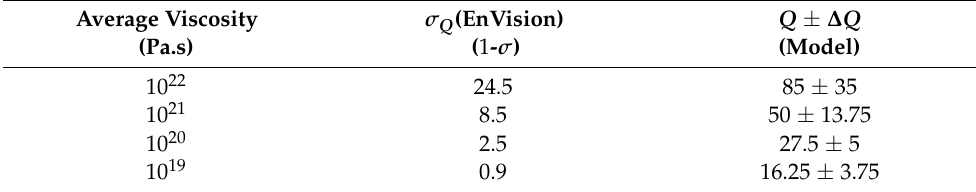
Figure 2. k 2 Love numbers computed for viscoelastic tidal deformation of Venus as a function of the core size and the averaged mantle viscosity. Three different composition models are tested, and two different temperature profiles (an Earth-like profile, symbols with contours, and one hotter without contours). See [14] for a complete description of the computation method, composition models and temperature profiles. Table 1. Expected error (1- σ ) σ Q of the EnVision solution and theoretical range ∆ Q of the Venus tidal dissipation factor Q as a function of the average mantle viscosity (see Table A2). The ∆ Q value for each averaged viscosity represents the variation of the viscoelastic deformation of the Andrade’s model used to account for the mantle rheology (see [14]). The σ Q error is derived from the error on the tidal phase angle δ(cid:101) (0.1 ◦ or 0.0017 radian, see Table A3) as follows: σ Q ≈ 2 Q 2 δ(cid:101)